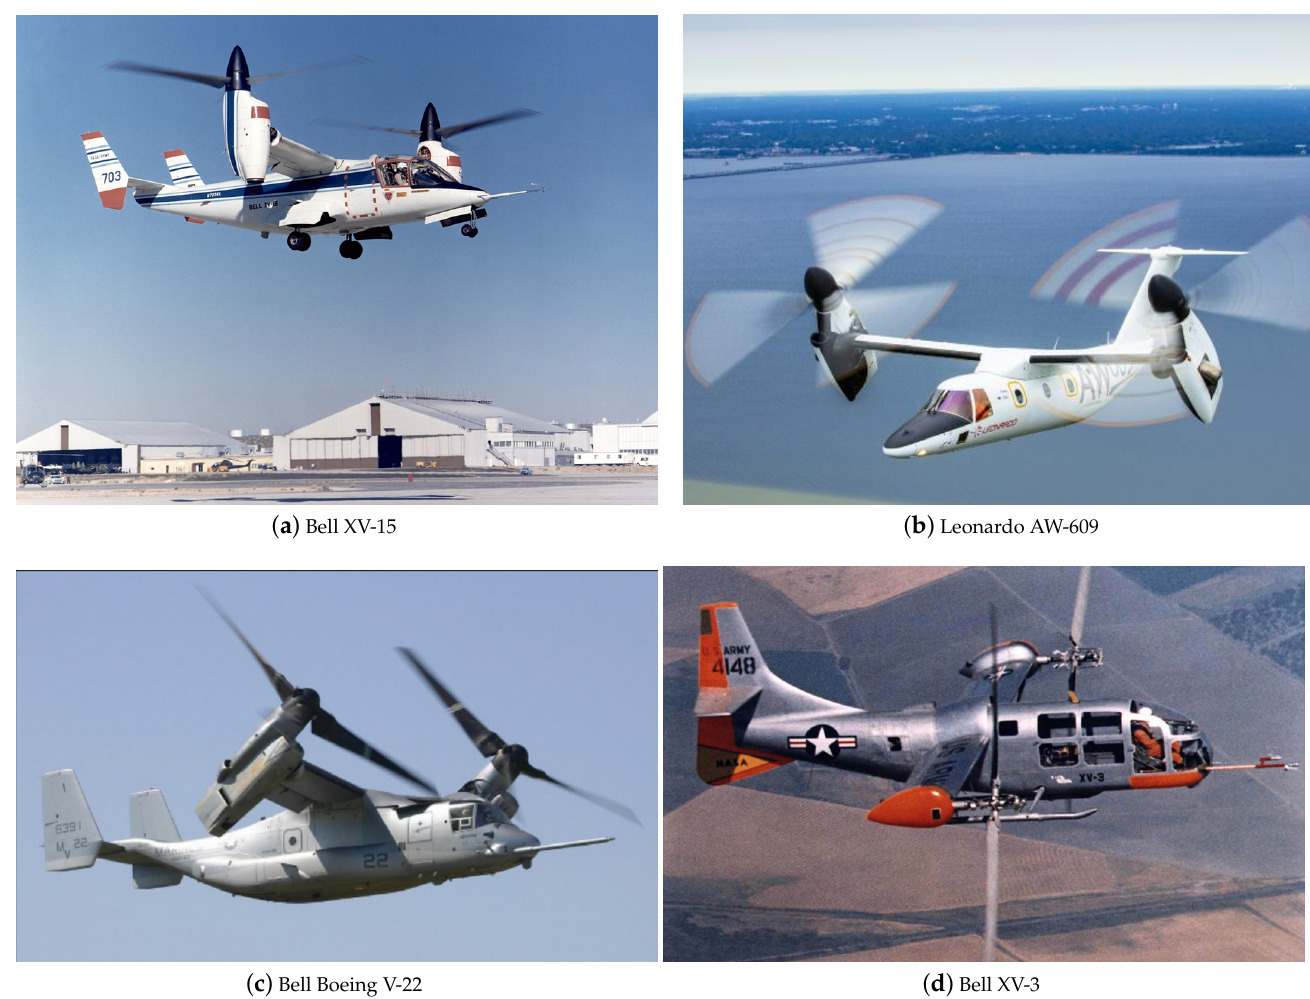
Figure 1. Examples of tiltrotor aircraft in different flight conditions: ( a ) Bell XV-15 in hover [8]; ( b ) Leonardo AW-609, in early conversion phase https://www.leonardocompany.com/it/products/aw609; ( c ) Bell Boeing V-22 in advanced conversion